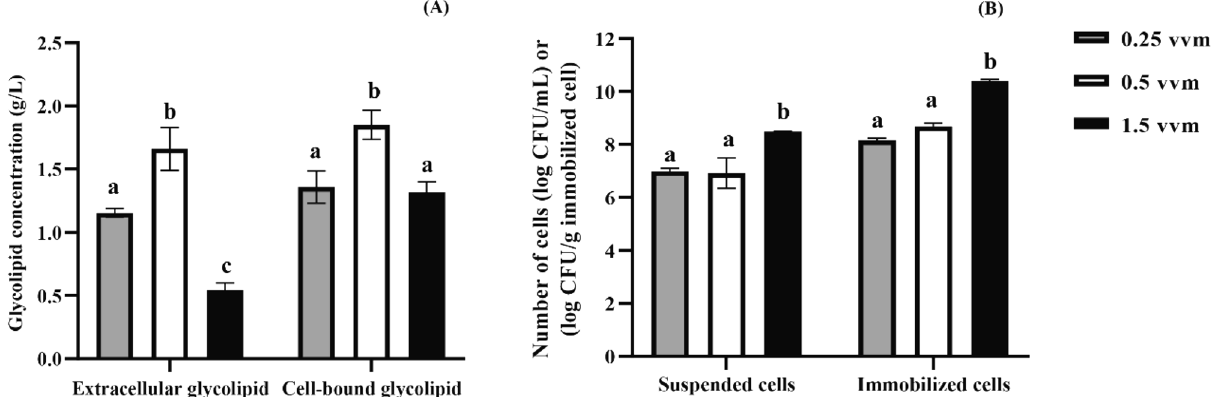
Figure 3. Crude glycolipid concentrations ( A ) and bacterial cell numbers ( B ) in a stirred tank fermenter with different aeration rates. The glycolipid concentration was based on the volume of productive medium. Error bars represent the standard deviation of the mean (n = 3). Two-way ANOVA: Tukey’s multiple comparison test was used for statistical analysis. Different letters represent statistically significant differences ( p <